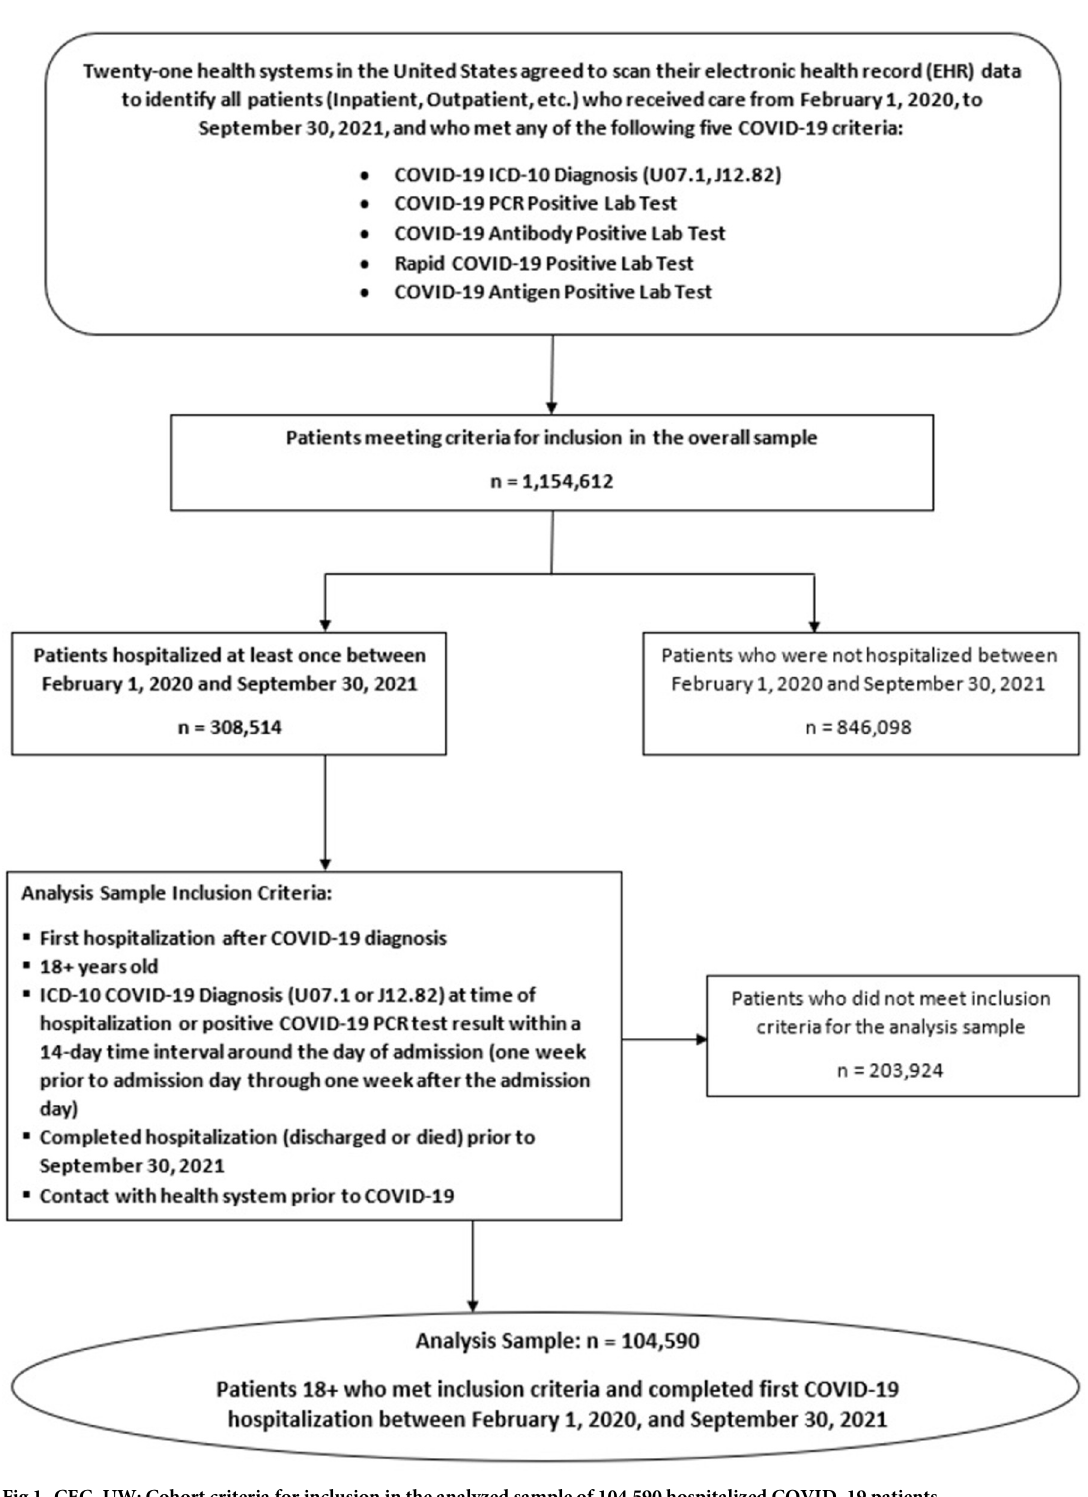
Fig 1. CEC–UW: Cohort criteria for inclusion in the analyzed sample of 104,590 hospitalized COVID–19 patients.